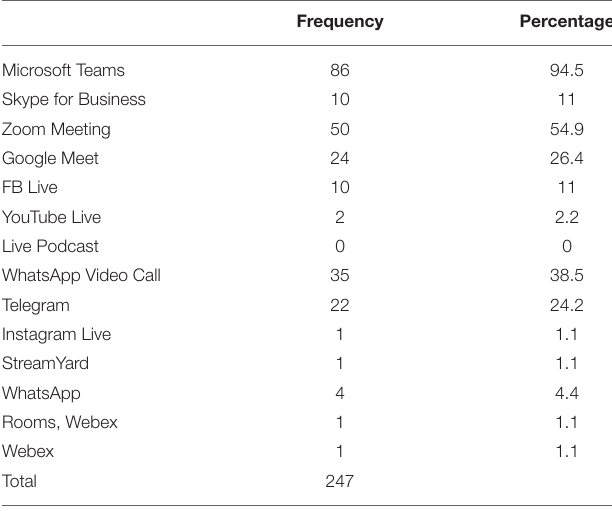
TABLE 11 | Frequency of usage of the computer lab among the staff. (Before COVID-19 pandemic).